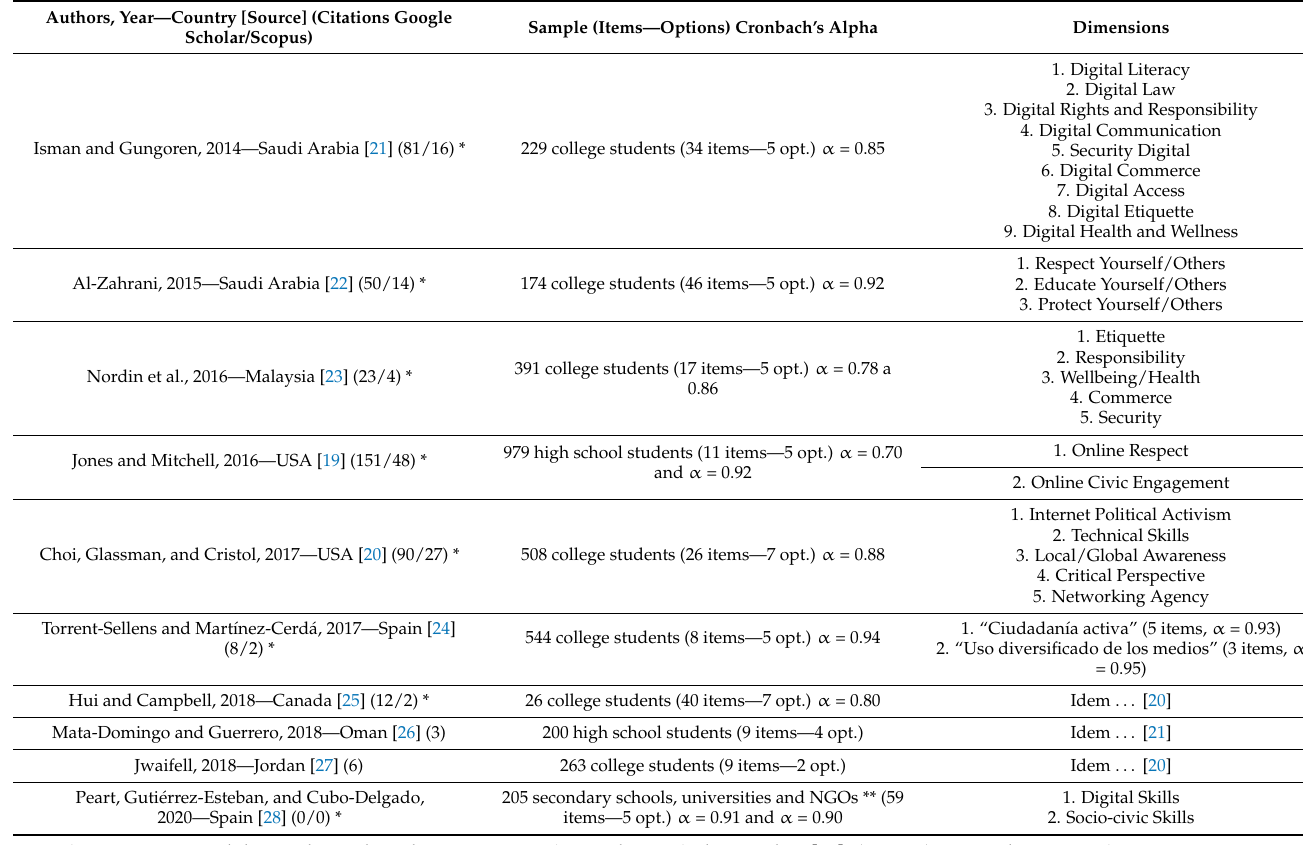
Table 2. Scales for measuring digital citizenship and psychometric